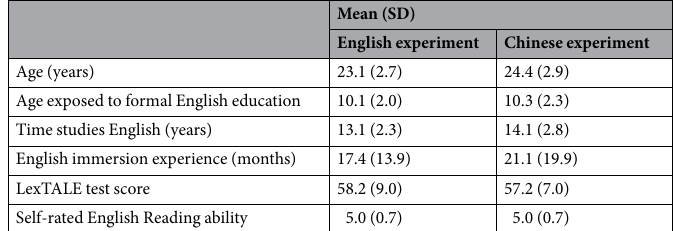
Table 1. Summary of the participants’ language background. Note . LexTALE 61 is an English vocabulary